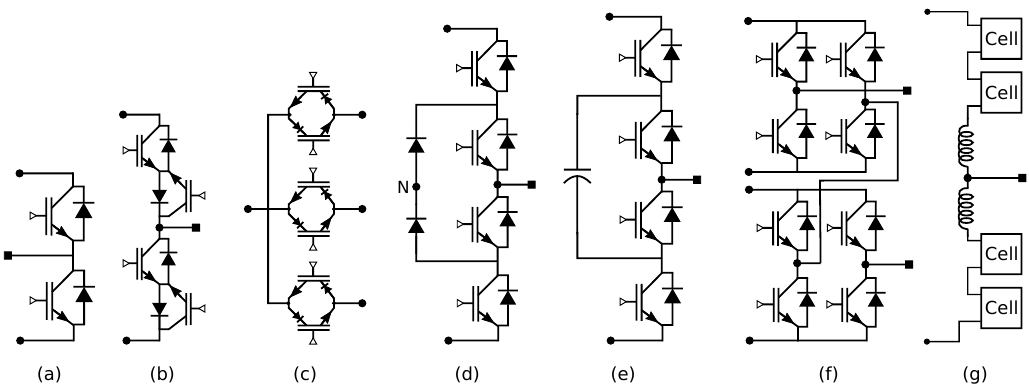
Figure 6. Topological equivalent of SST IPM at module-level: ( a ) Half bridge phase leg [40], ( b ) Matrix converter phase leg [41], ( c ) Matrix converter phase leg using reversed blocking-IGBT [41], ( d ) Neutral point clamped converter phase leg [42,43], ( e ) Flying capacitor phase leg [44], ( f ) Cascaded H-bridge phase leg [45,46], and ( g ) Modular multilevel converter phase leg [47].